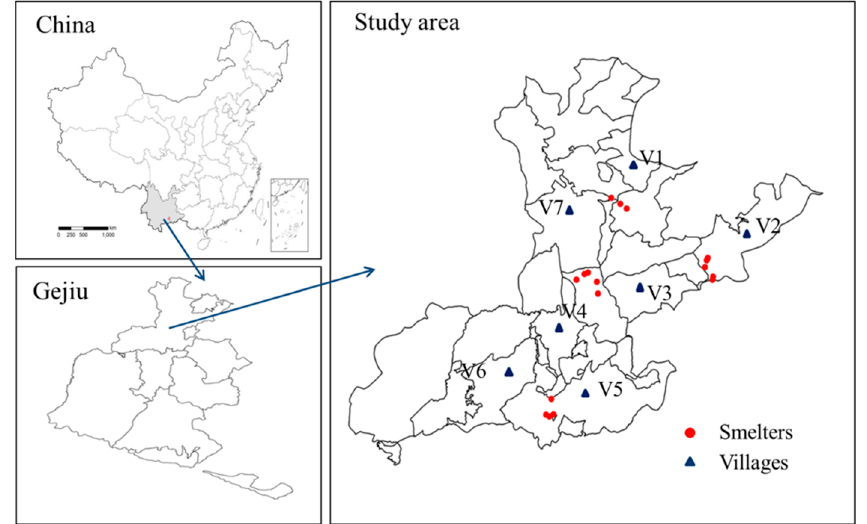
Figure 1. Location of sampling villages affected by smelting activities in suburban of Gejiu,